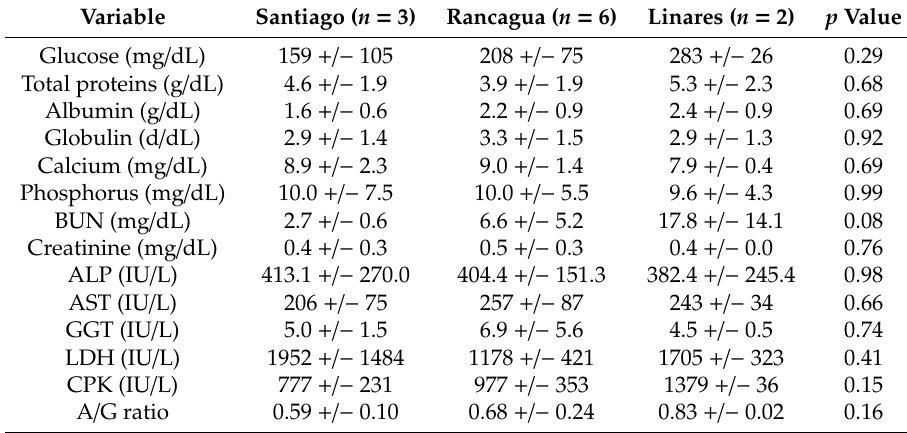
Table 4. Mean ± standard deviation of blood biochemistry variables of captive black-faced ibis ( Theristicus melanopis ) according to sampling location (N =